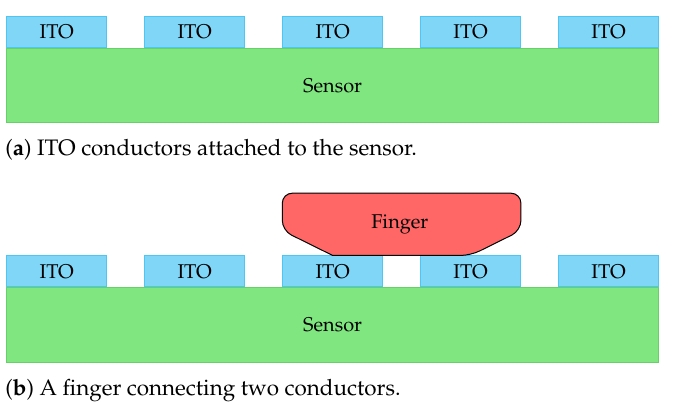
Figure 3. The ITO conductors are structured vertically on the capture device to lie in the same direction as the fingers.